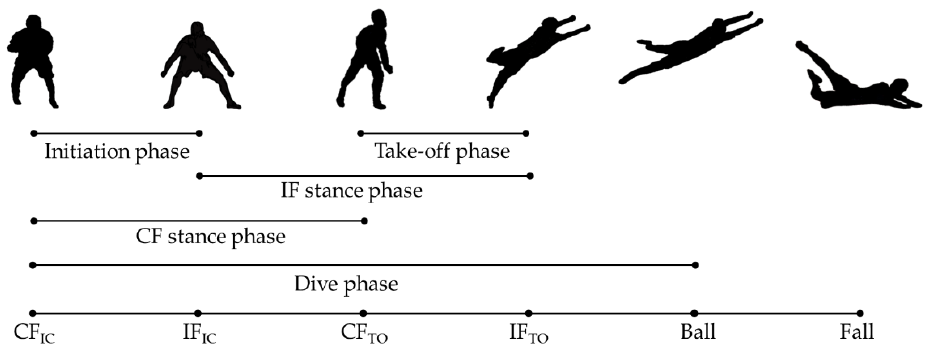
Figure 4. Dive phase division. Note: CF IC : Contralateral foot initial contact; IF IC : Ipsilateral foot initial contact; CF TO : Contralateral foot toe-off; IF TO : Ipsilateral foot toe-off; Ball: the contact with the ball; Fall: contact with the ground (mattress).